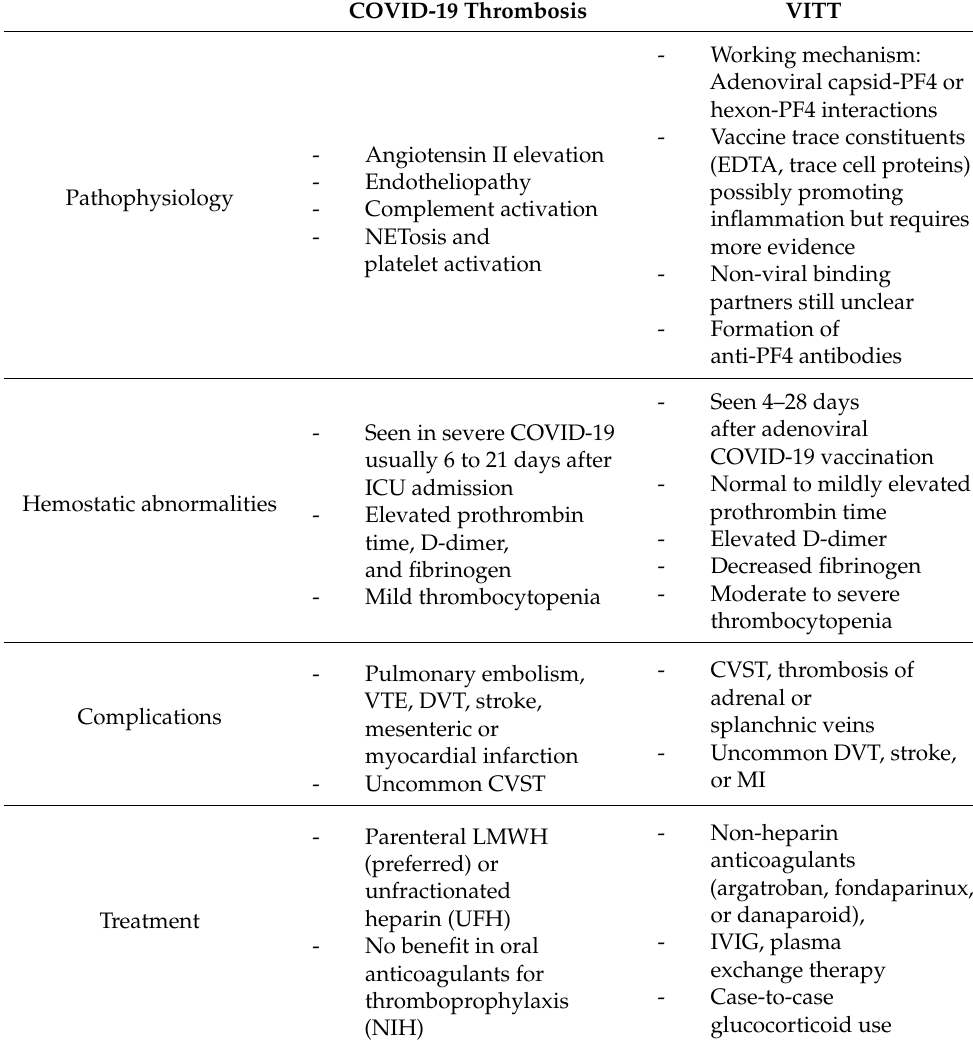
Table 1. Brief comparison between COVID-19 thrombosis and